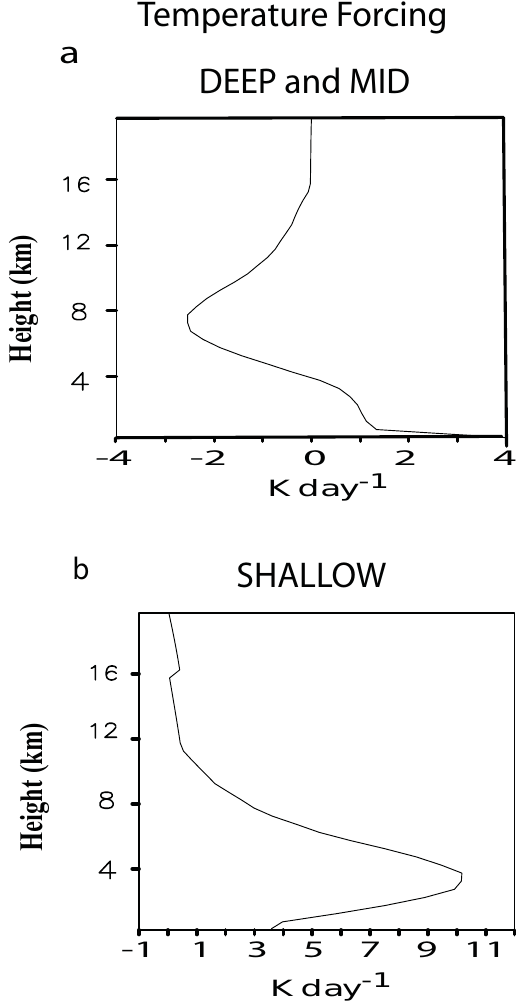
Fig. 4. Time- and domain-averaged vertical distribution of potential temperature large-scale forcing (Kday − 1 ) for (a) DEEP and MID and for (b)